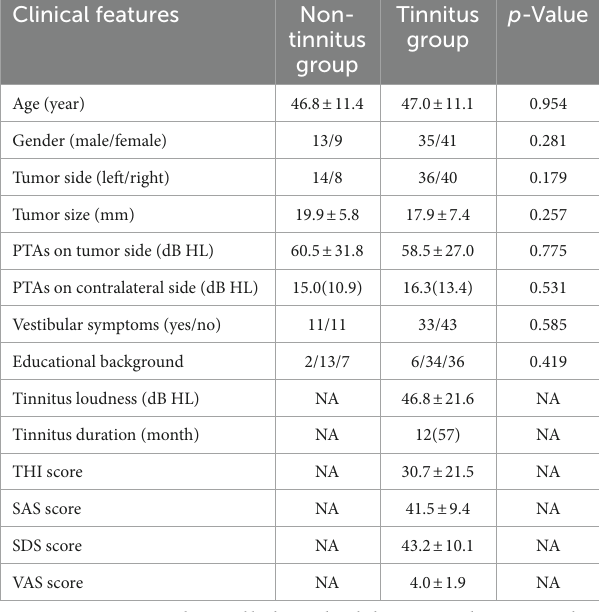
TABLE 1 Clinical characteristics of vestibular schwannoma patients. Clinical